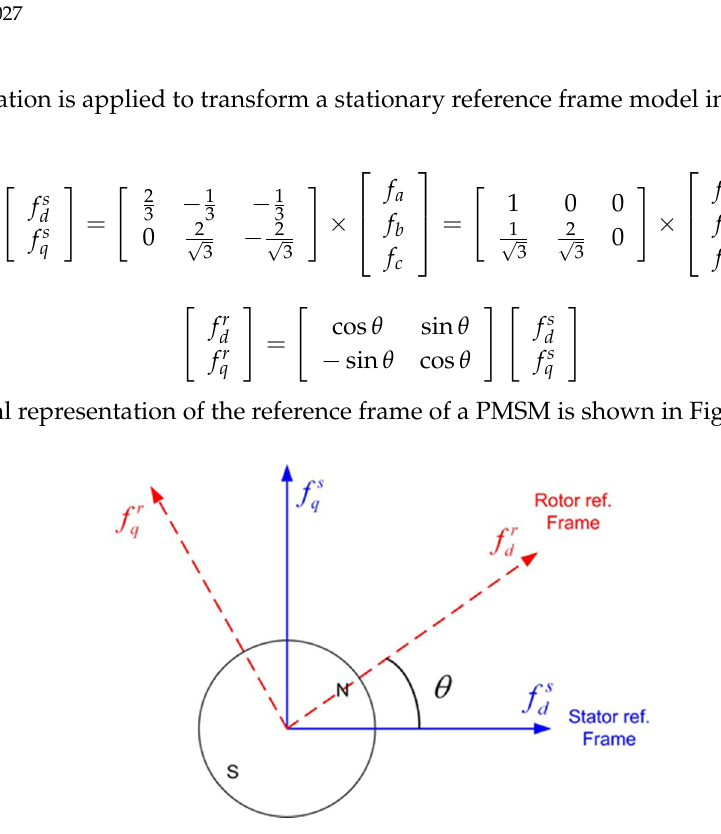
Figure 1. Stationary and rotor reference frame notation of a PMSM (permanent magnet synchronous motor). In Equations (1) and (2), subscripts d and q represent the d and q axes and superscripts s and r represent a stationary reference frame and a rotor reference frame, respectively. In (2), θ is the rotor position of a PMSM, as shown in Figure 1. Applying the Clarke and Park transformation, an IPMSM model at a rotor reference frame can be derived. In Equations (3) and (4), differential equations of stator flux linkage, stator current and air-gap torque for IPMSM drives at a rotor reference frame are shown, where p indicates the time